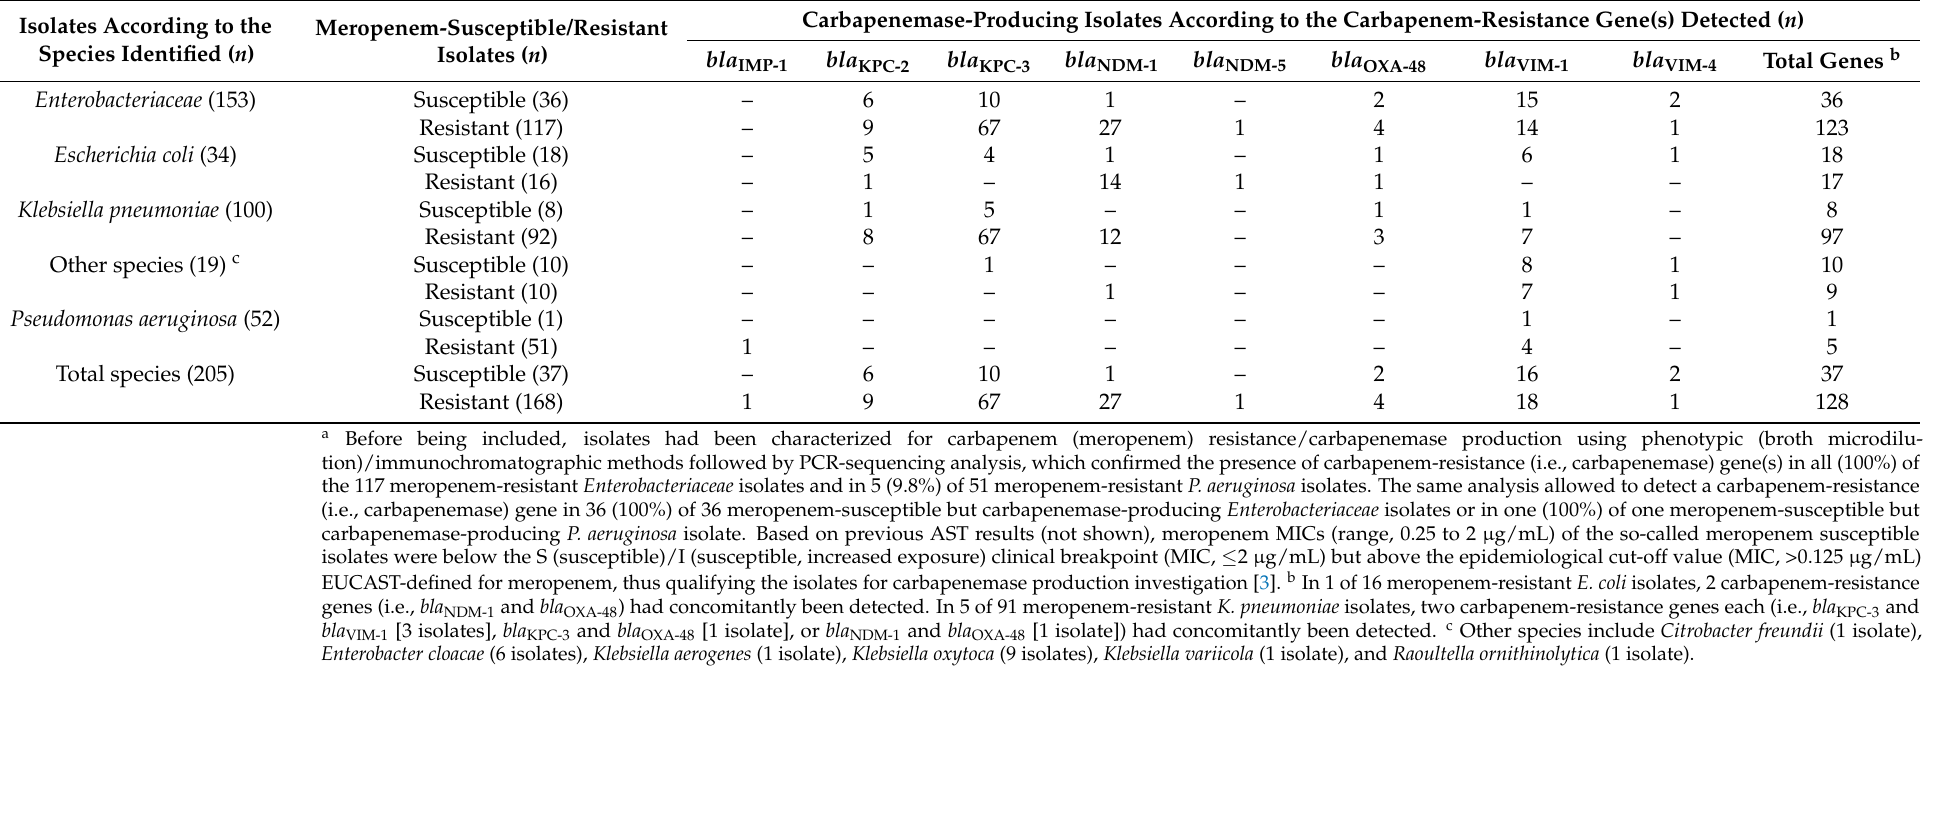
Table 1. Phenotypic and genotypic characteristics of 205 Gram-negative bacterial isolates included in the study a